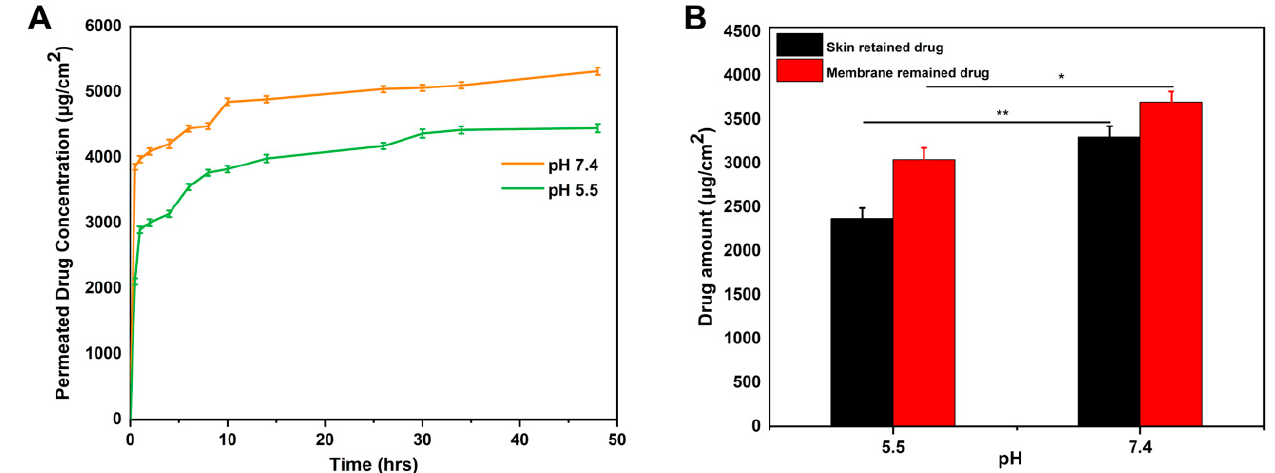
Figure 10. In vitro skin permeation study of optimized hydrogel membrane formulation (SPA-1) at both normal skin pH (5.5) and wounds pH (7.4) ( A ). The amount of drug retained in the hydrogel membrane or deposited on the mice skin is also shown ( B ). (Here, * shows the p value < 0.05, and ** p <